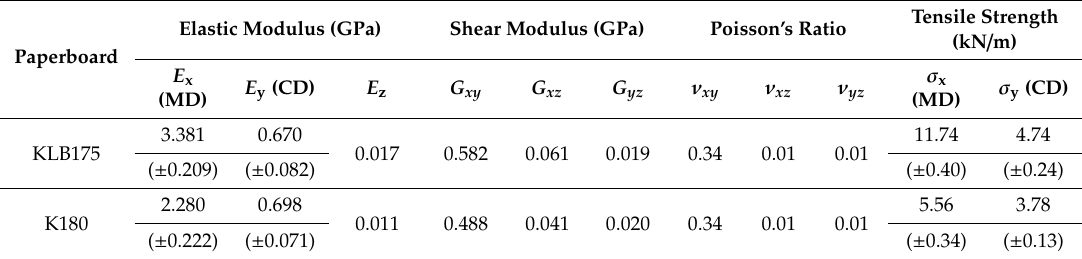
Table 3. Material properties of corrugated paperboard components applied to FEA.